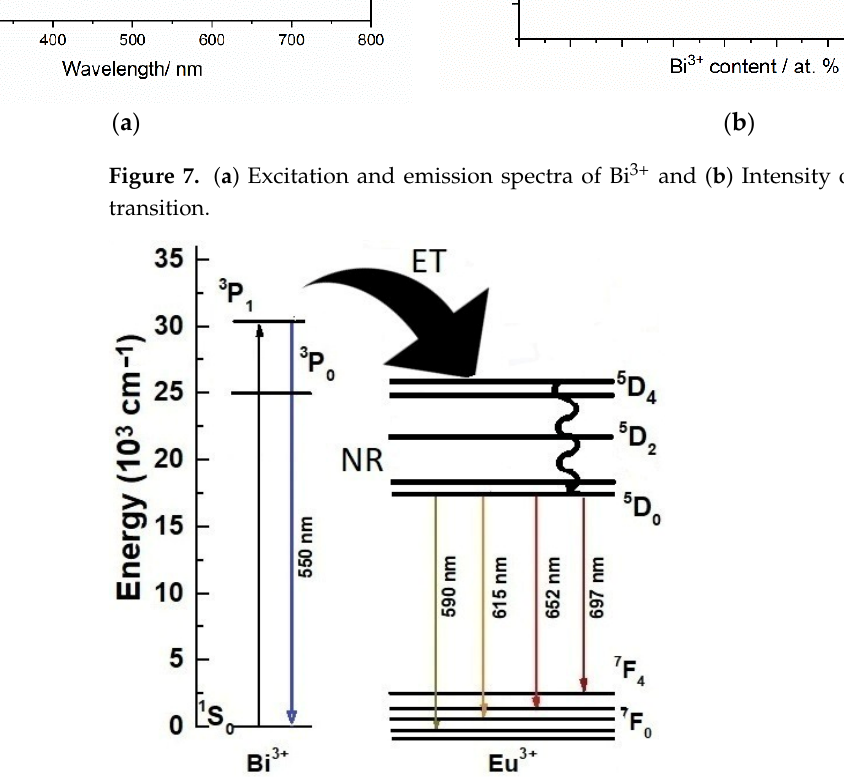
Figure 8. Energy level diagram of Bi 3+ and Eu 3+ in LuVO 4 .